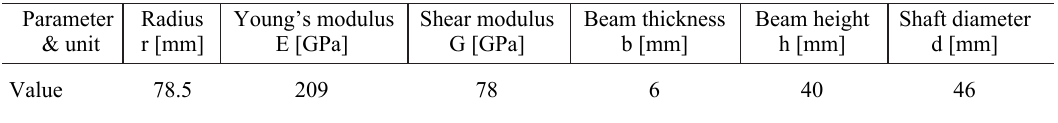
Table 1. Geometrical and material parameters used in the analytical calculations